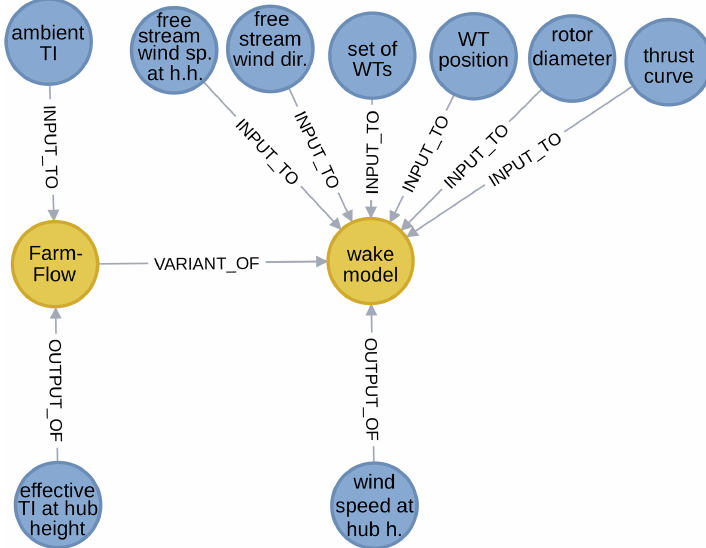
Figure 12. The model node for the FarmFlow wake tool and its surroundings in the graph (excerpt from